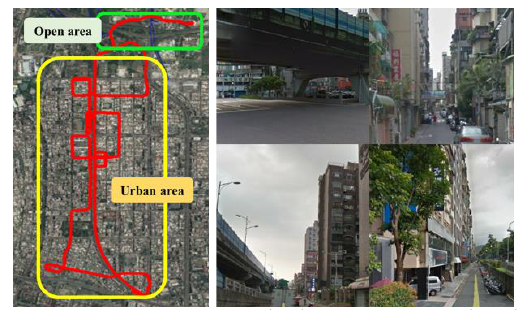
Figure 8. Experiment trajectory (left) and street views (right)